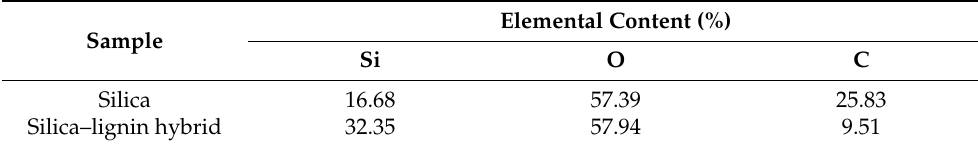
Table 4. Elemental content of silica and silica–lignin hybrid based on EDX analysis.